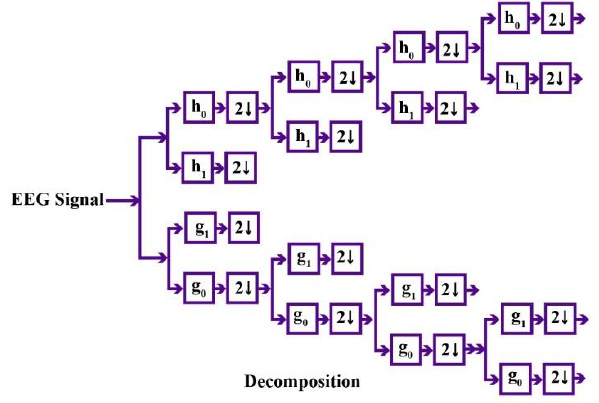
Figure 3. Exemplary EEGs from five samples of the Freiburg dataset.